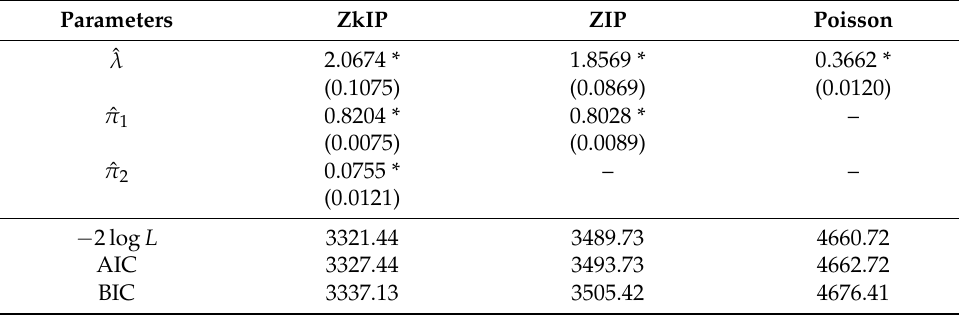
Table 12. The model description of off days